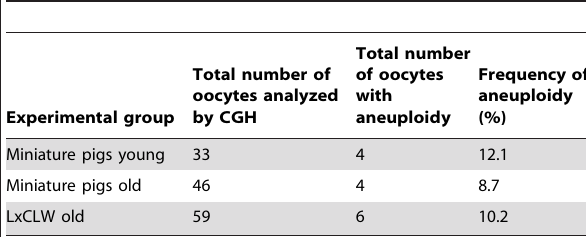
Table 2. The frequency of aneuploidy in oocytes from young donors versus oocytes from aged donors.